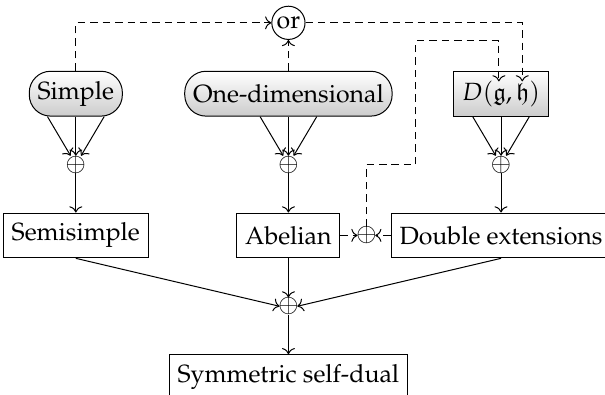
Figure 2. This diagram shows how all Lie algebras with an invariant metric, i.e., symmetric self-dual Lie algebras, are constructed. The fundamental indecomposable building blocks are the simple and the one-dimensional Lie algebras, and they need to be accompanied by the operations of direct sums ( ⊕ ) and double extensions ( D ( g , h ) ). Direct sums of simple and one-dimensional Lie algebras lead to semisimple and abelian ones, respectively. To construct new indecomposable Lie algebras that admit an invariant metric, one needs to double extend an abelian or an already double extended Lie algebra (as explained, it should not have a simple